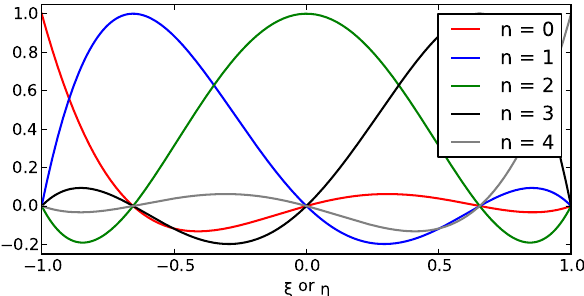
Figure 3. Lagrangian basis polynomials l n (ξ) of fourth order in one dimension. At the collocation points, all but one are zero, such that the value of the interpolated function at this point coincides with the coefficient in this basis